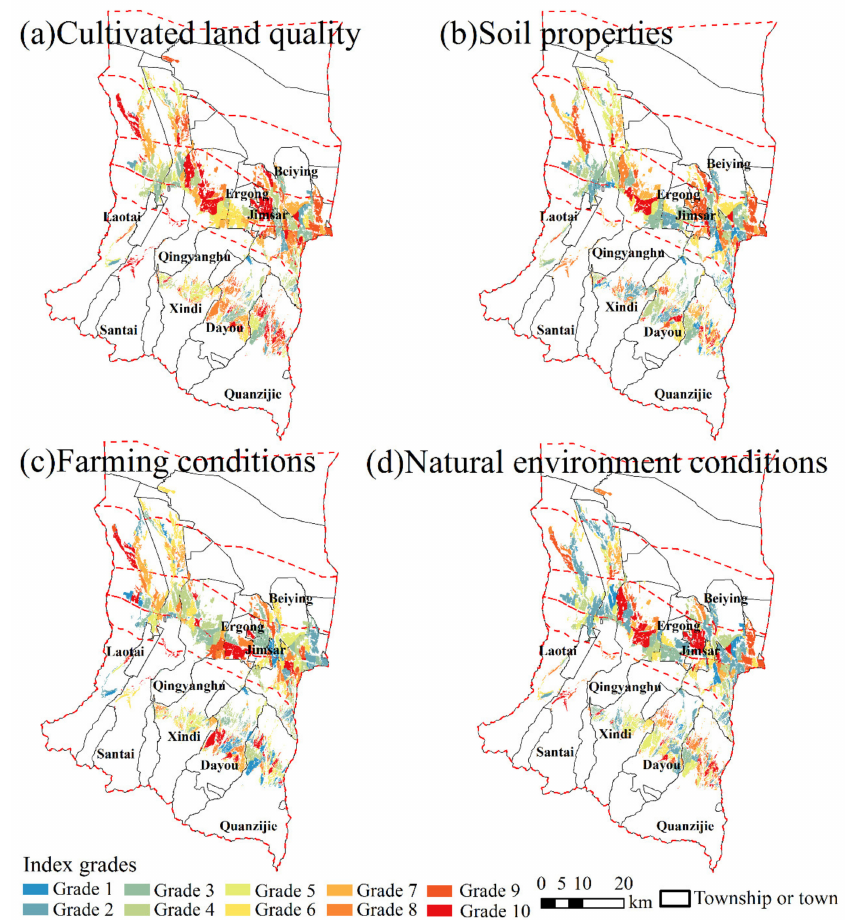
Figure 4. Spatial distribution of the cultivated land quality and three dimensions index grades. ( a ) Cultivated land quality evaluation results. ( b ) Soil property dimension evaluation results. ( c ) Farming condition dimension evaluation results. ( d ) Natural environment condition dimension evaluation